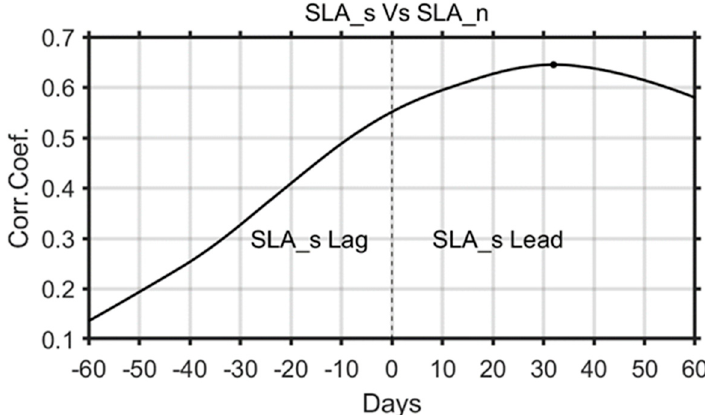
Figure 7. Lead / lag correlation between SLA at Station 26 (SLA_n) and that at Station 1 (SLA_s) using data from January 2003 to December 2016. The x -coordinate represents the number of days, a positive value of which indicates a leading SLA_s, and the y -coordinate represents the correlation coefficient.